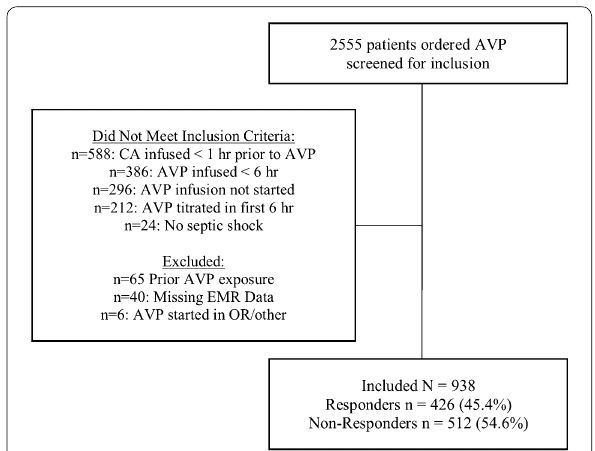
Fig. 1 Patient inclusion and exclusion tree. There were 2555 patients screened for inclusion into the study. Of the screened patients, 1506 patients did not meet initial inclusion criteria and 111 met exclusion criteria leaving 938 patients included in the evaluation. AVP arginine vasopressin; CA catecholamine; EMR electronic medical record;